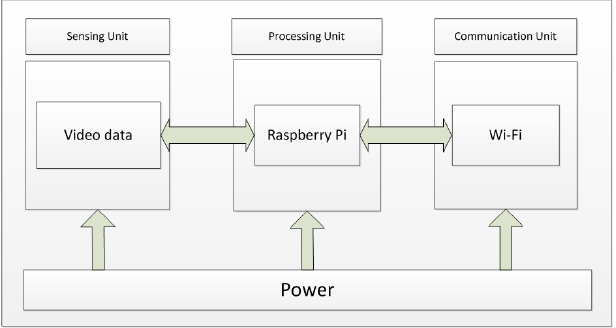
Figure 1. Sensor node architecture.